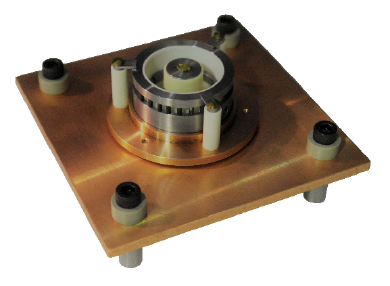
Figure 2. ISCT100-v2, 100 W-class HT.